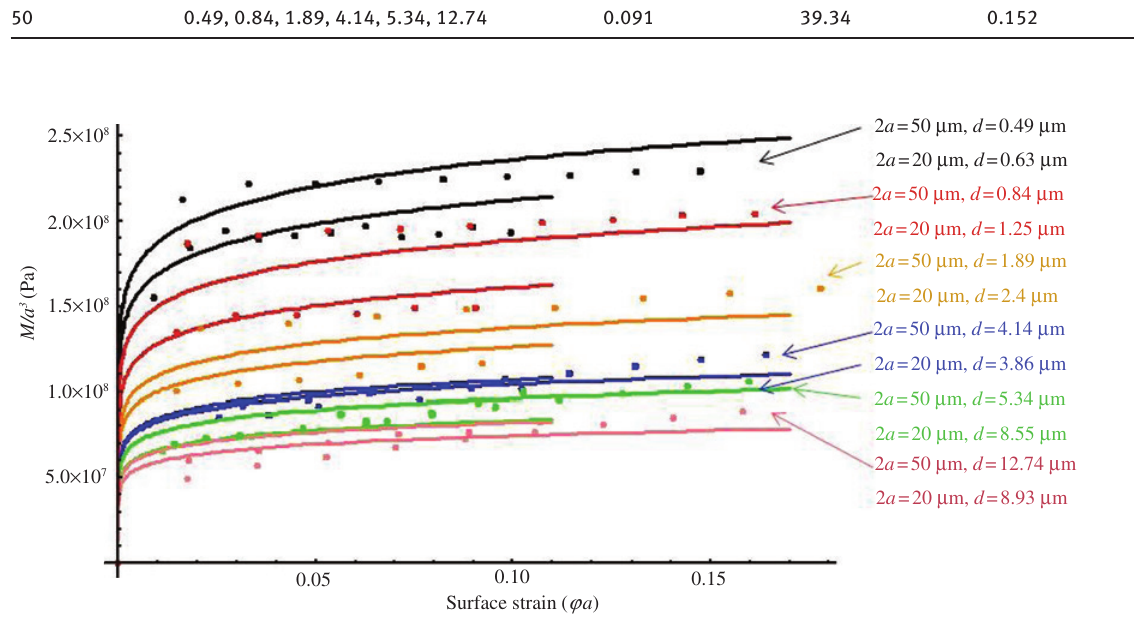
Figure 2: Comparison between the theoretical predictions of Eq. (14) (lines) and the experimental data of Gan et al. [11] (points).